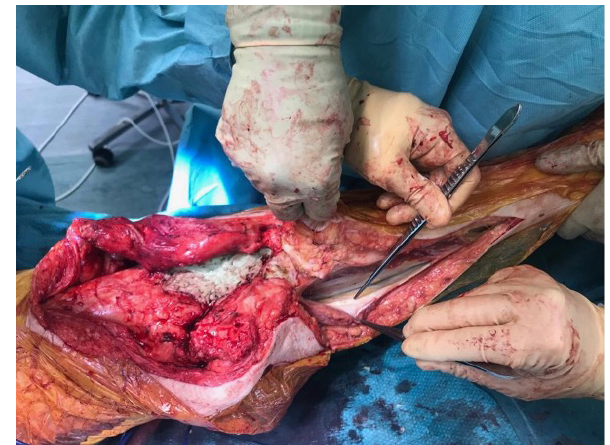
Figure 1. Extension of incision to identify the medial gastrocne- mius muscle belly.